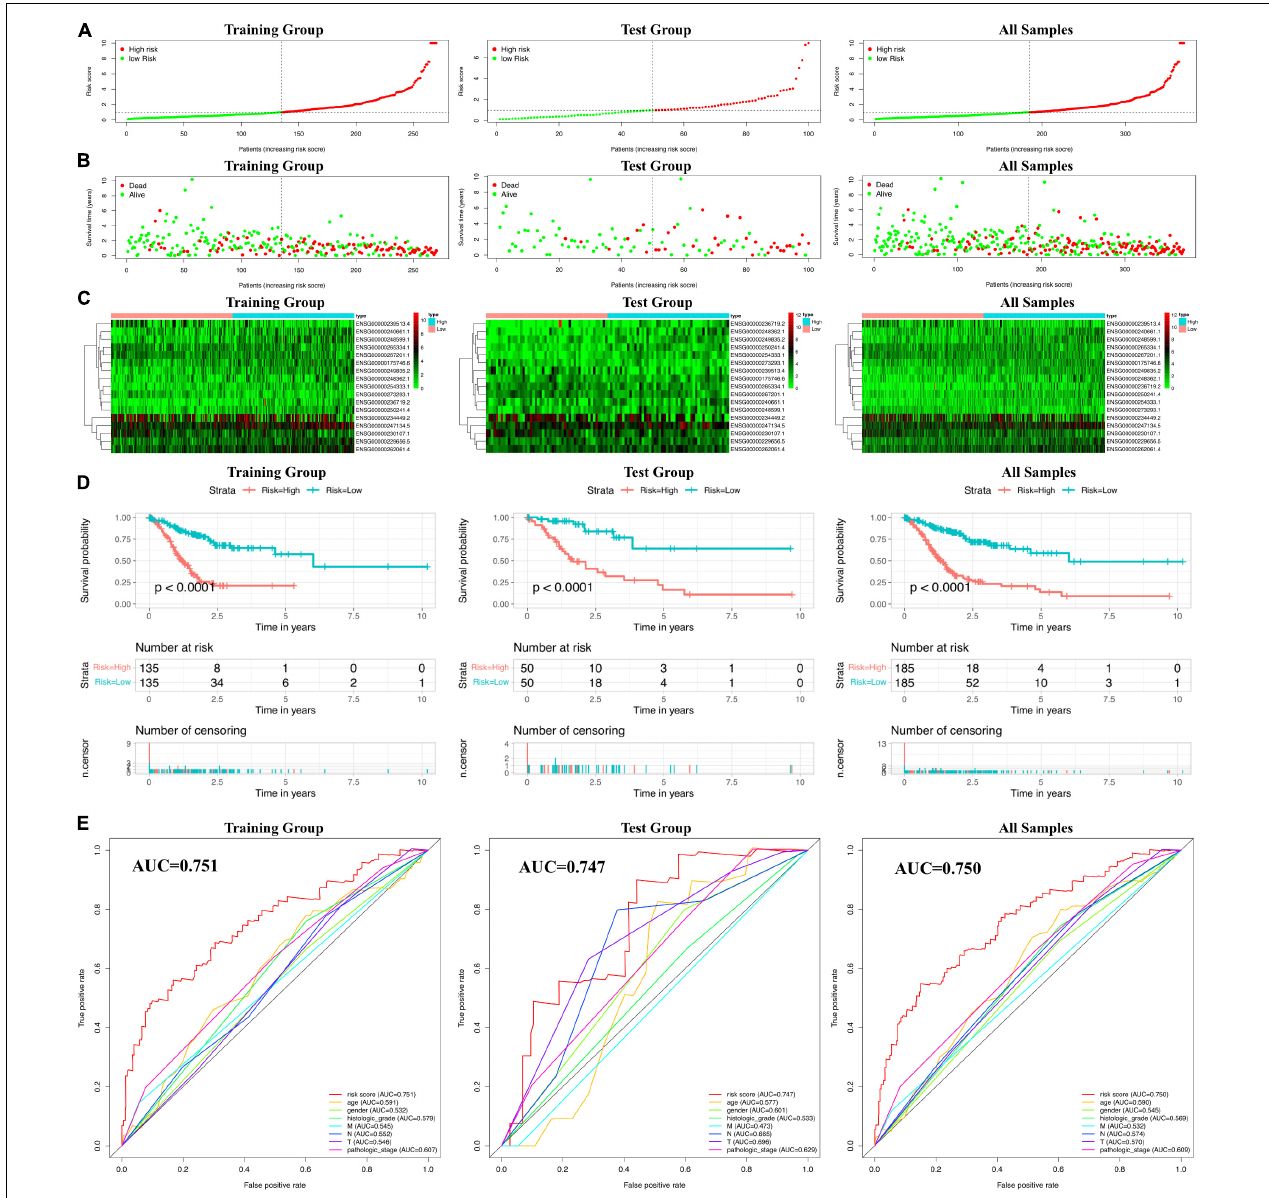
FIGURE 4 | Prognostic risk scores calculated using the ferroptosis-related lncRNA-based prognostic model. (A) Distribuion of patients’ risk scores. (B) Patients’ overall survival (OS) status distribution. (C) Prognostic signature signal heatmaps. (D) Kaplan–Meier (K-M) survival curves for patients separated into the High-Risk and Low-Risk groups. (E) Receiver operating characteristic (ROC) curve analysis for verification of the prognostic value of the prognostic model based on 17 ferroptosis-related lncRNAs.